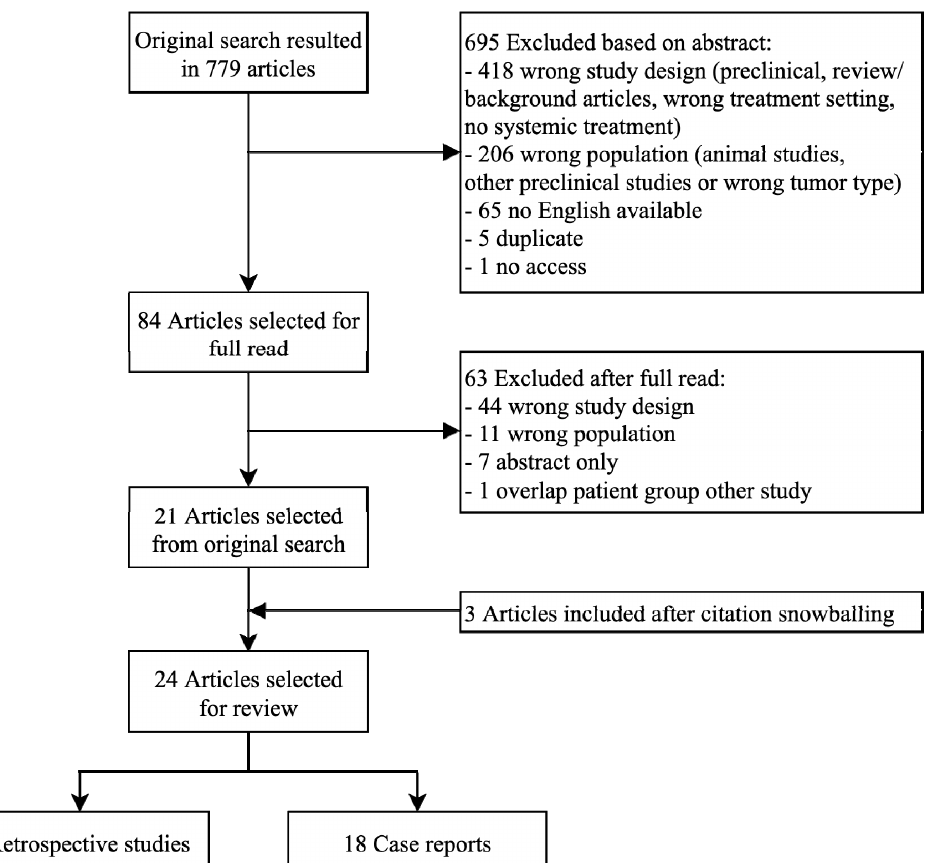
Figure 1. Schematic overview of search strategy.